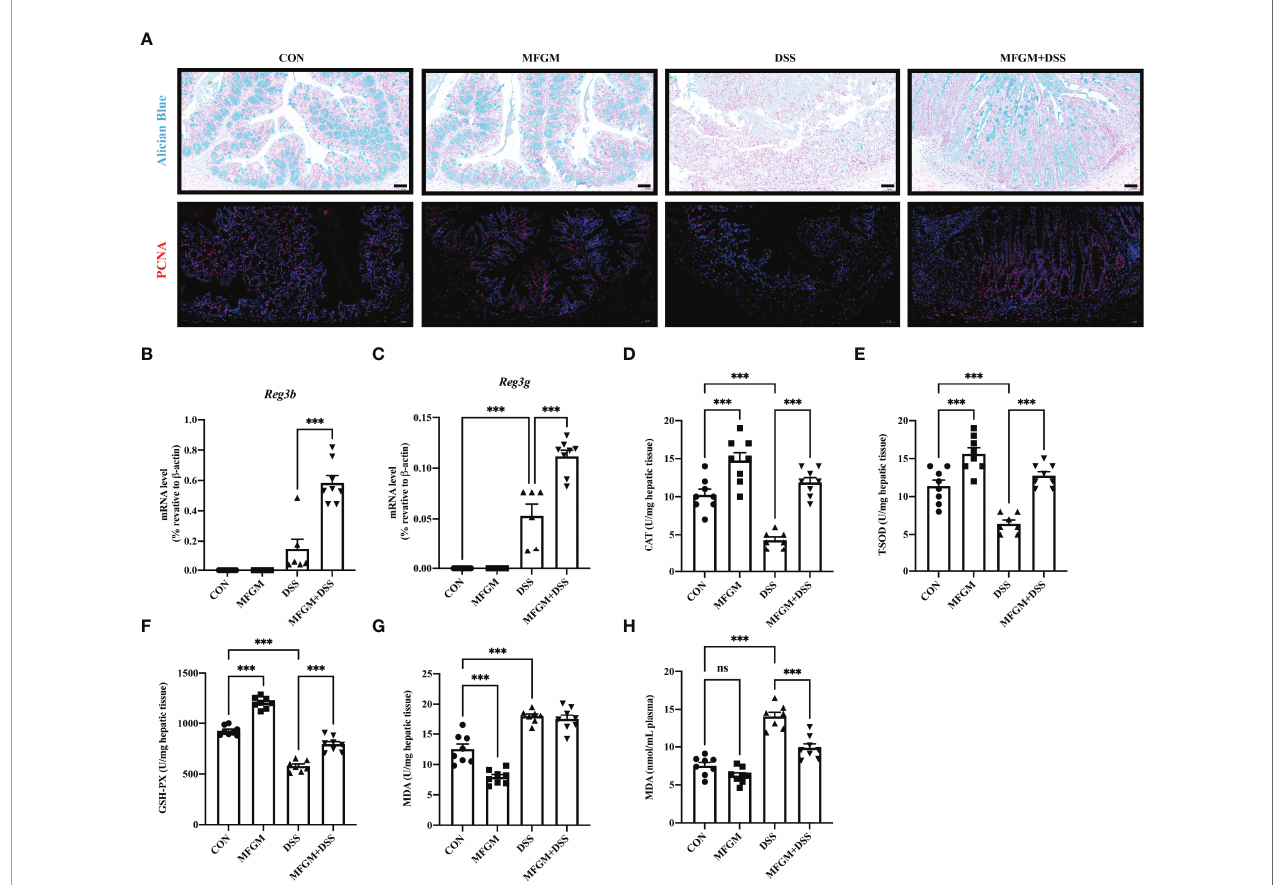
FIGURE 6 | Milk fat globule membrane (MFGM) maintained the colonic mucus barrier and regulated the oxidative stress of the liver. (A) Representative images of Alcian blue-stained inner mucus layer and proliferating cell nuclear antigen-stained colonic epithelia of colonic sections. Scale bars represent 50 m m. mRNA expression of Reg3b (B) and Reg3g (C) in the colon. Concentrations of CAT (D) , T-SOD (E) , GSH-PX (F) , and MDA (G) in the hepatic tissues. (H) Level of MDA in the plasma ( n = 6 – 8 per group). Data are presented as means ± SEM ( n = 8 per group). Statistical signi fi cance was determined using one-way ANOVA, followed